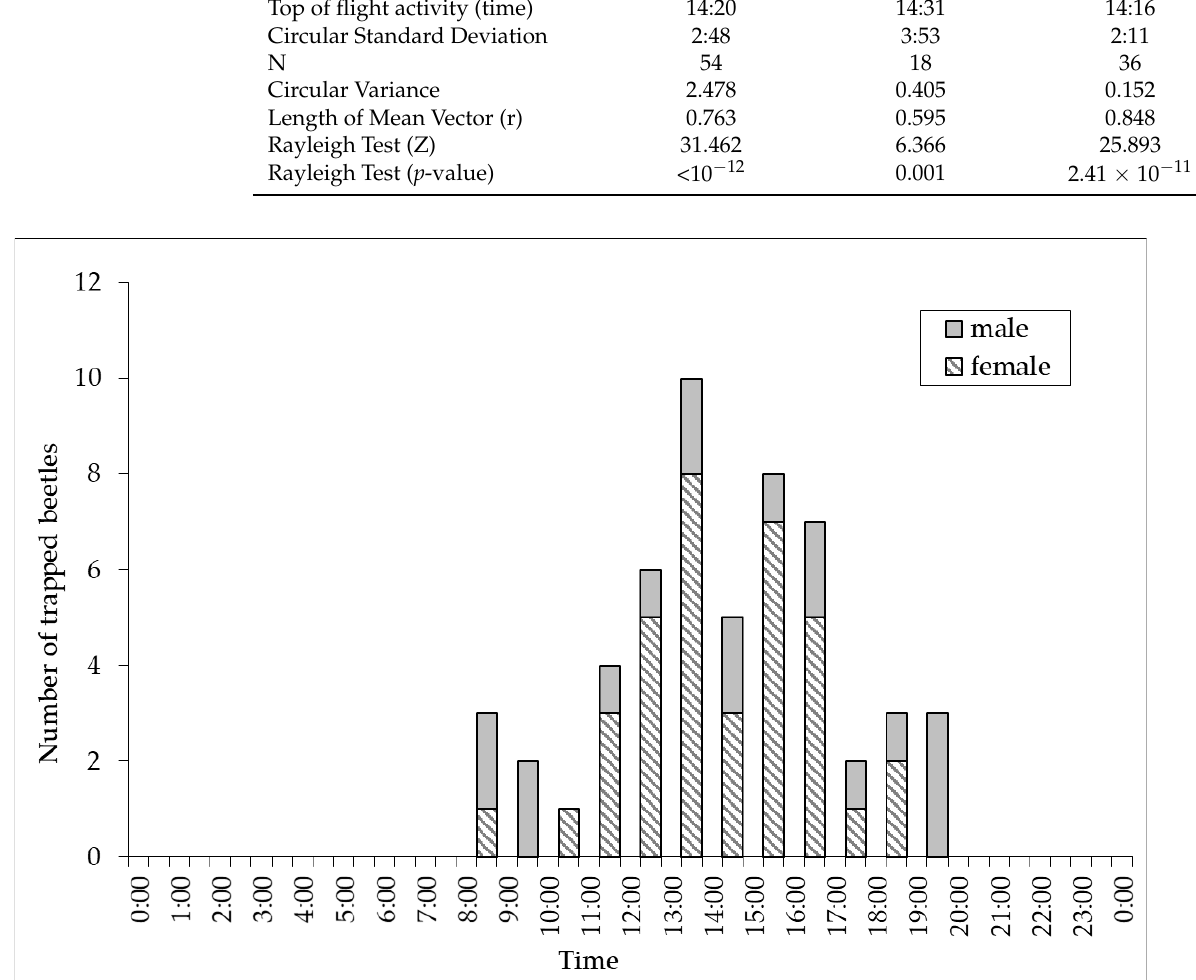
Figure 3. Diurnal flight activity recorded by window traps in period 21–23 May–June 2013 . Table 1. Results of diurnal flight activity for the species, and separately for males and females (2013).